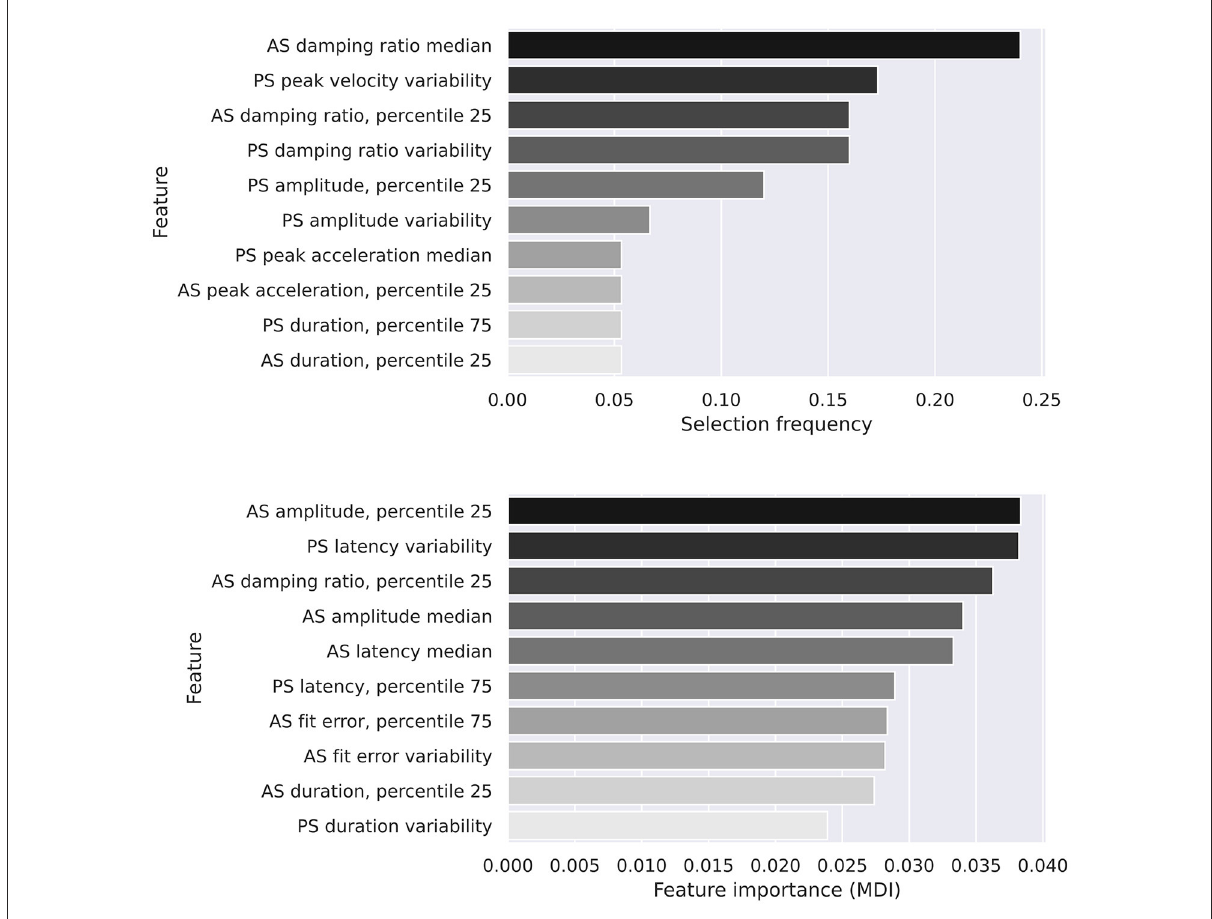
FIGURE6 The top 10 features in each classifier. Top , logistic regression. Bottom , random forest.